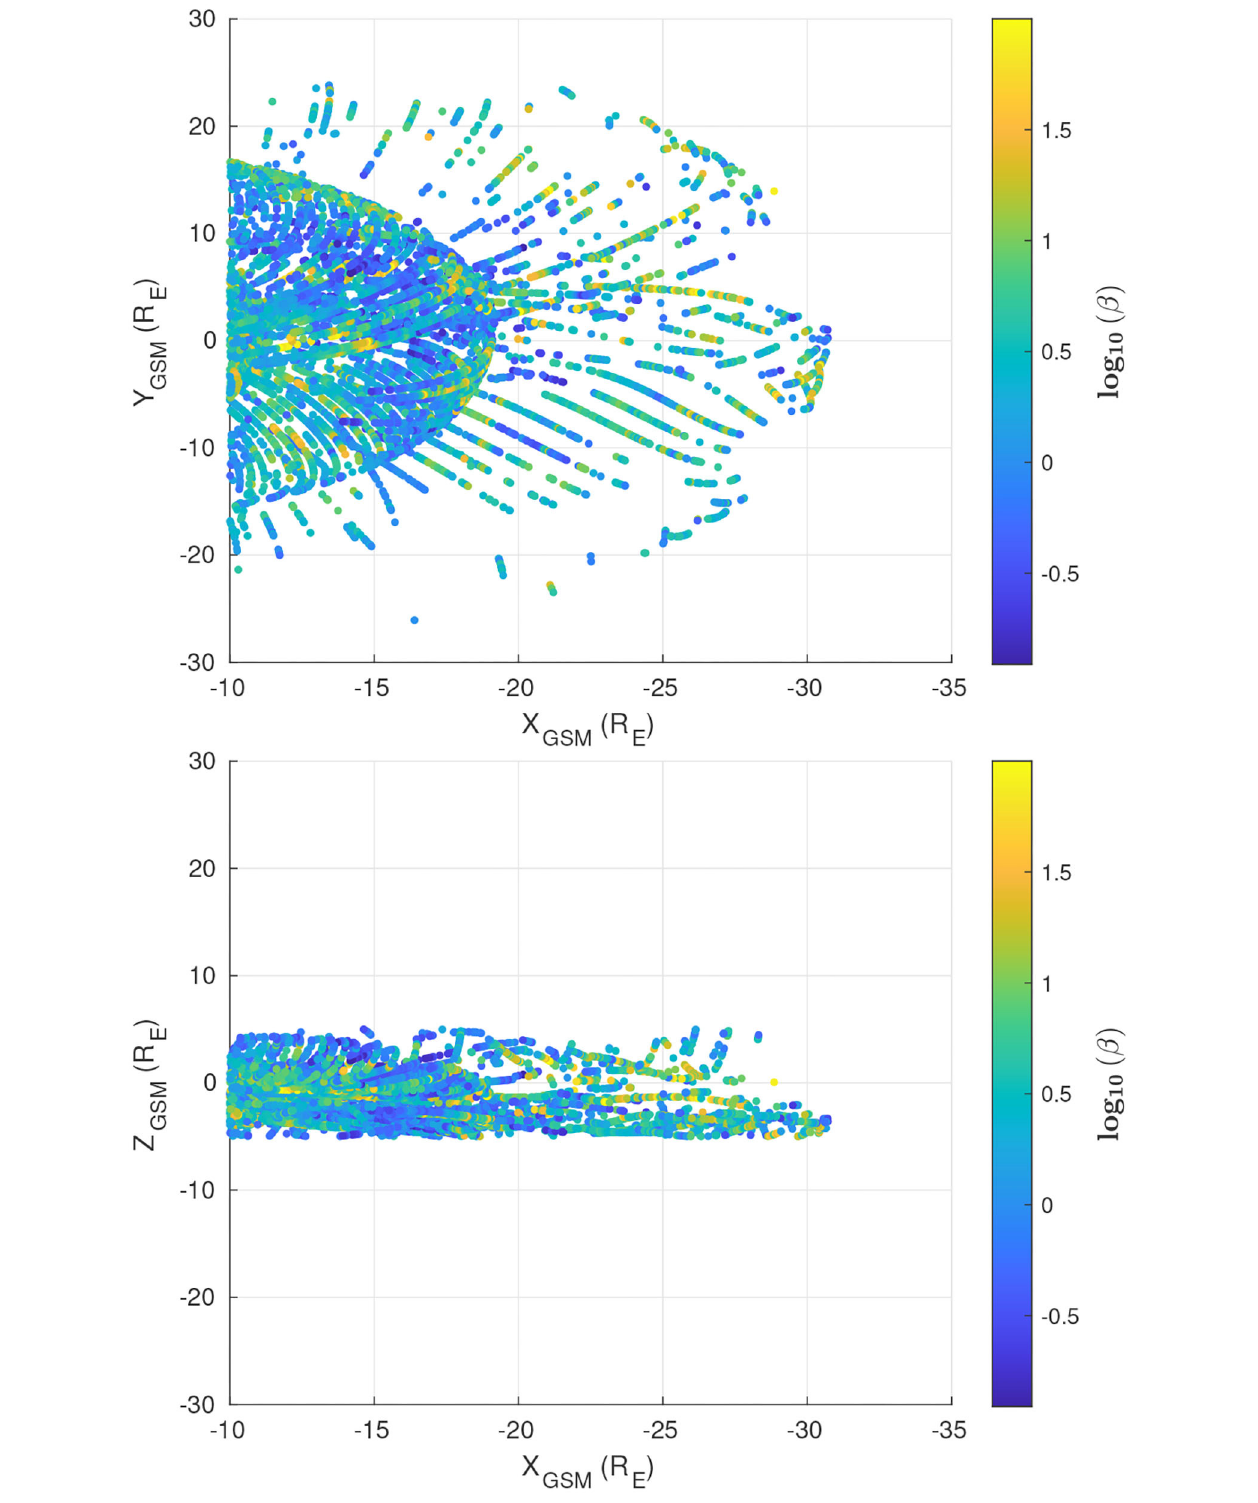
FIGURE 4 | Spatial coverage of the time intervals used in the study. (Top) The X - Y gsm plane. (Bottom) The X - Z gsm plane. The 12-min averaged plasma β at each location is represented with the color scale.